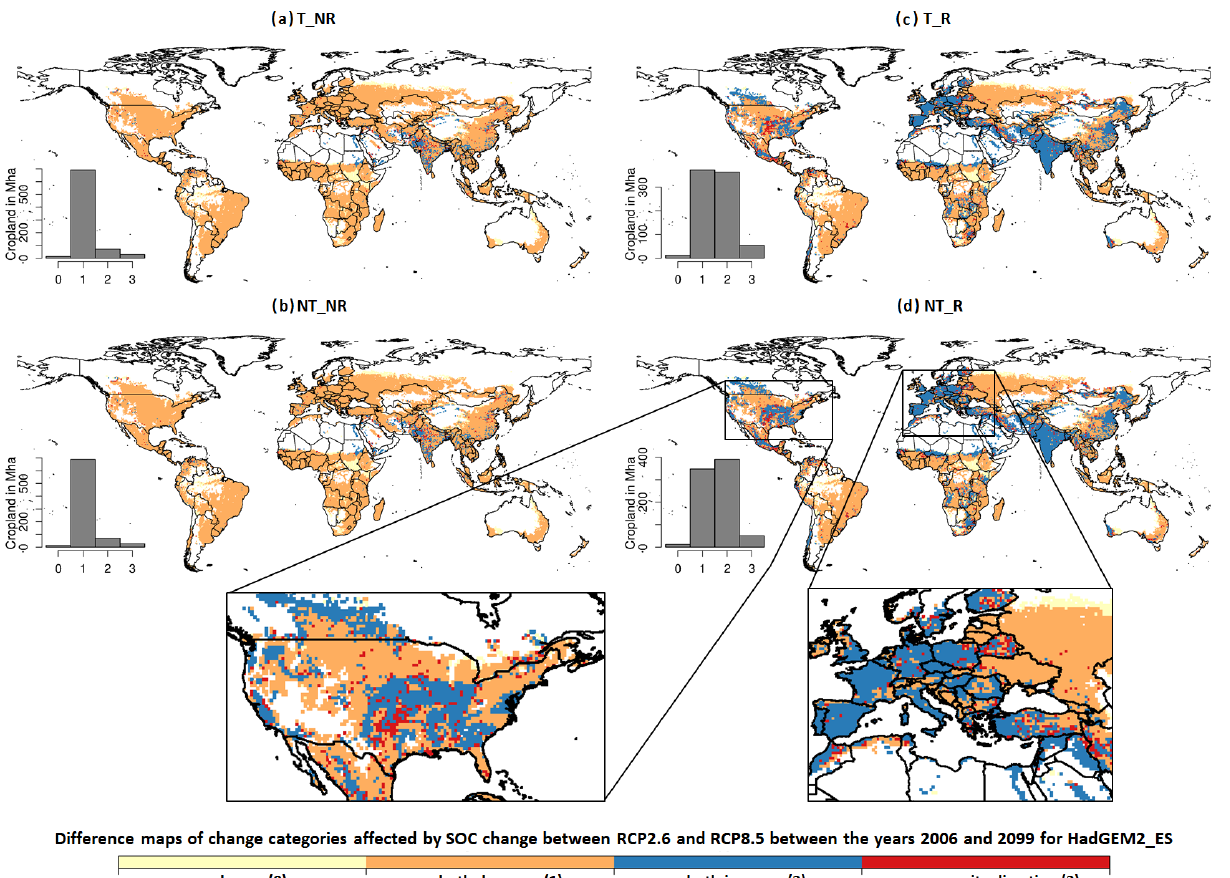
Figure 6. Difference maps of change categories for cropland SOC density change between RCP2.6 and RCP8.5 from the year 2006 until 2099 for GCM HadGEM_ES in each management system. Orange areas indicate a reduction in cropland SOC density between the years 2006 and 2099 in both RCPs, and blue areas show an increase in SOC density; in light yellow areas no change occurs, and for red areas SOC density change occurs in opposite directions in RCP2.6 and RCP8.5. The numbers in brackets (0 to 3) correspond to the categories in the